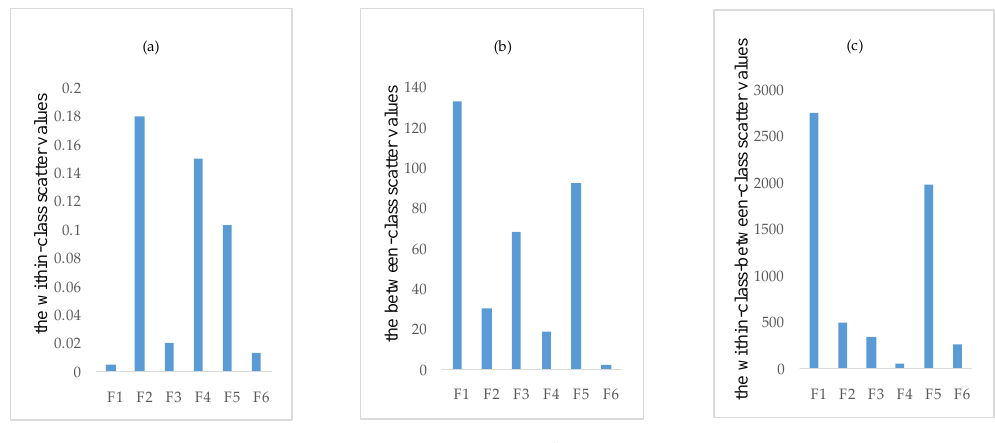
Figure 7. Divergence-calculation results of six di ff erent fault-feature sets in experiment data 2. ( a ) Within-class scatter values corresponding to di ff erent measurement methods; ( b ) between-class scatter values corresponding to di ff erent measure methods; and ( c ) within-class–between-class scatter values corresponding to di ff erent measure